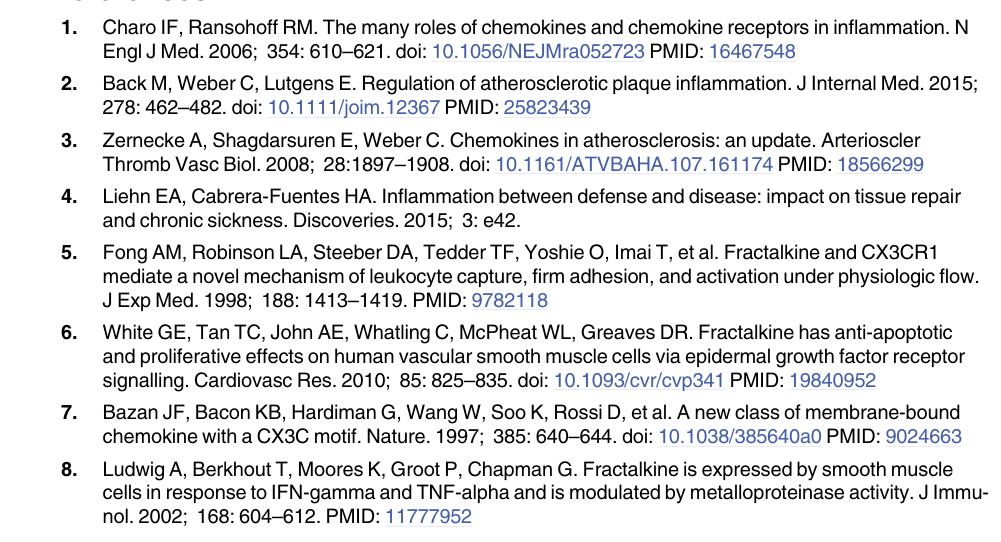
We would like to thank Roya Soltan, Melanie Garbe, Stephanie Elbin, and Yuan Kong for their excellent technical